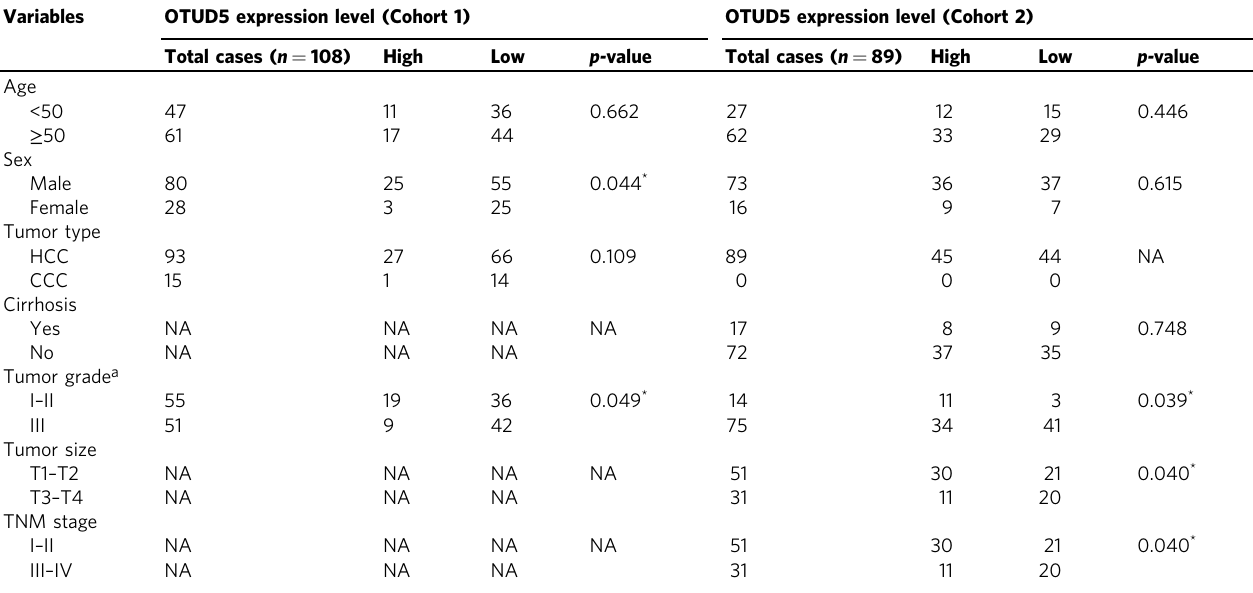
Table 1 OTUD5 was correlated with clinical pathologic characteristics of liver cancer patients.